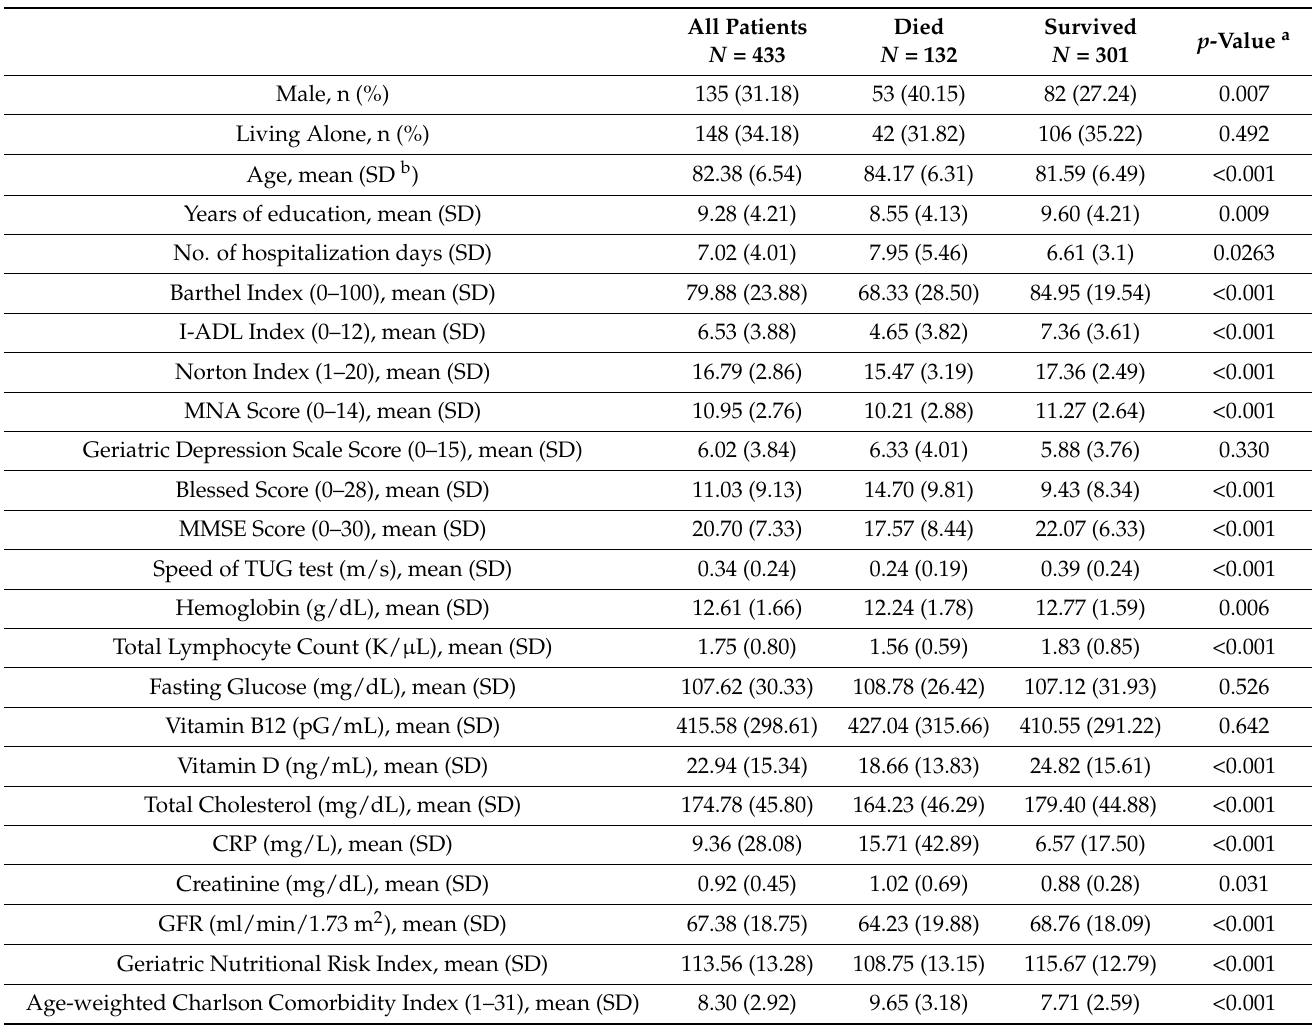
Table 1. Descriptive statistics of geriatric